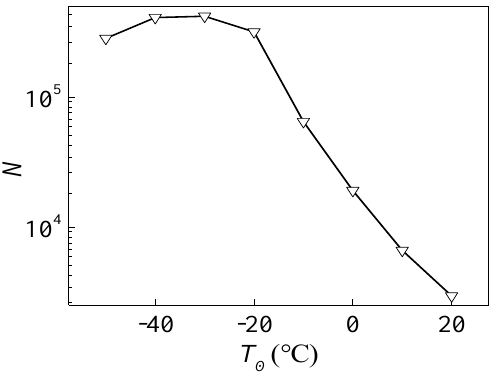
Figure 12. E ff ects of the ambient temperature on the thermal fatigue lives of the key solder